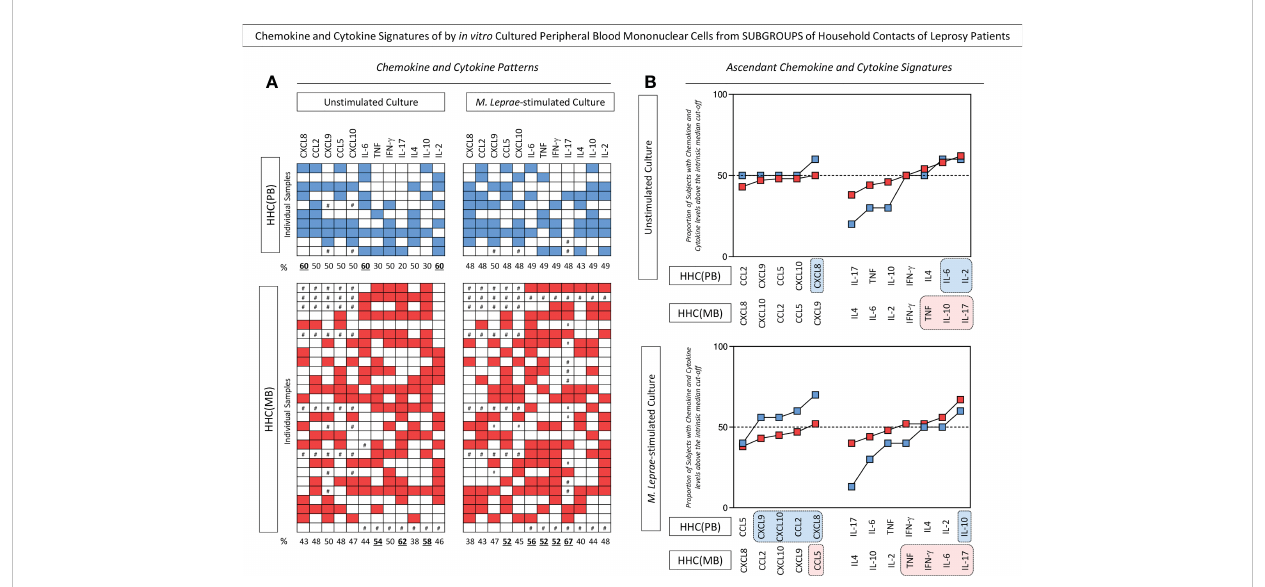
FIGURE 2 Chemokine and cytokine signatures of in vitro cultured peripheral blood mononuclear cells from subgroups of household contacts of leprosy patients. The levels of chemokines (CXCL8, CCL2, CXCL9, CCL5, CXCL10) and cytokines (IL-6, TNF, IFN- g , IL-17, IL-4, IL-10 and IL-2) were measured in